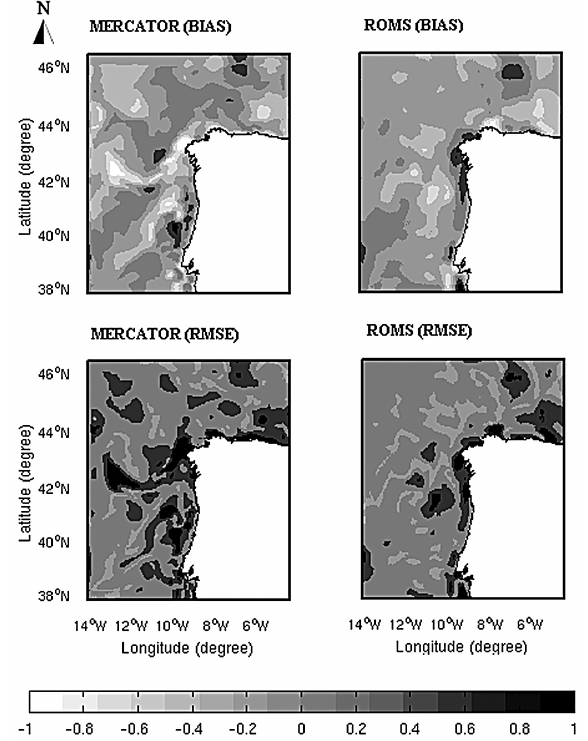
f ig . 13. – Horizontal distribution of the statistical parameter RMSE and BIAS for sea surface temperature in August 2010: (left) MER- CATOR model and (right) ROMS